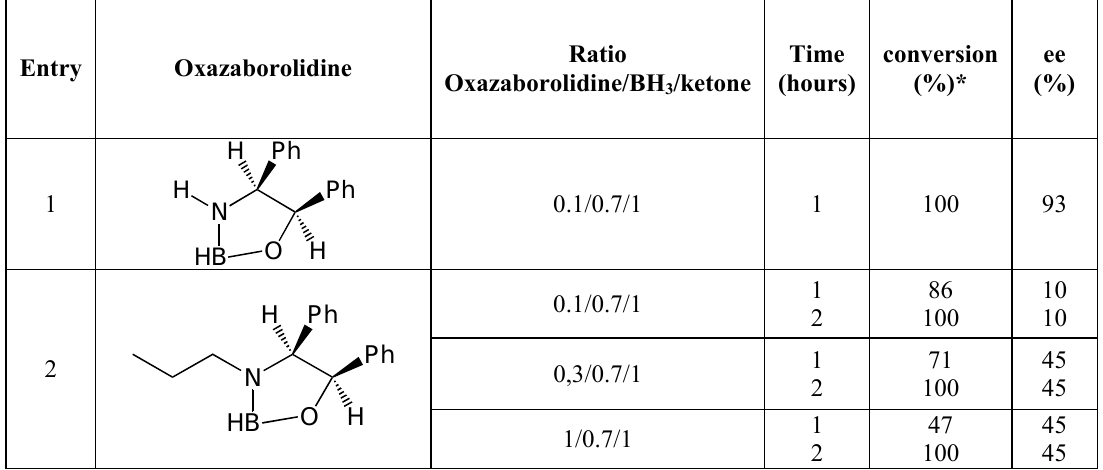
Table 4. Influence of the nitrogen substituent of the oxazaborolidine on the enantioselectivity.